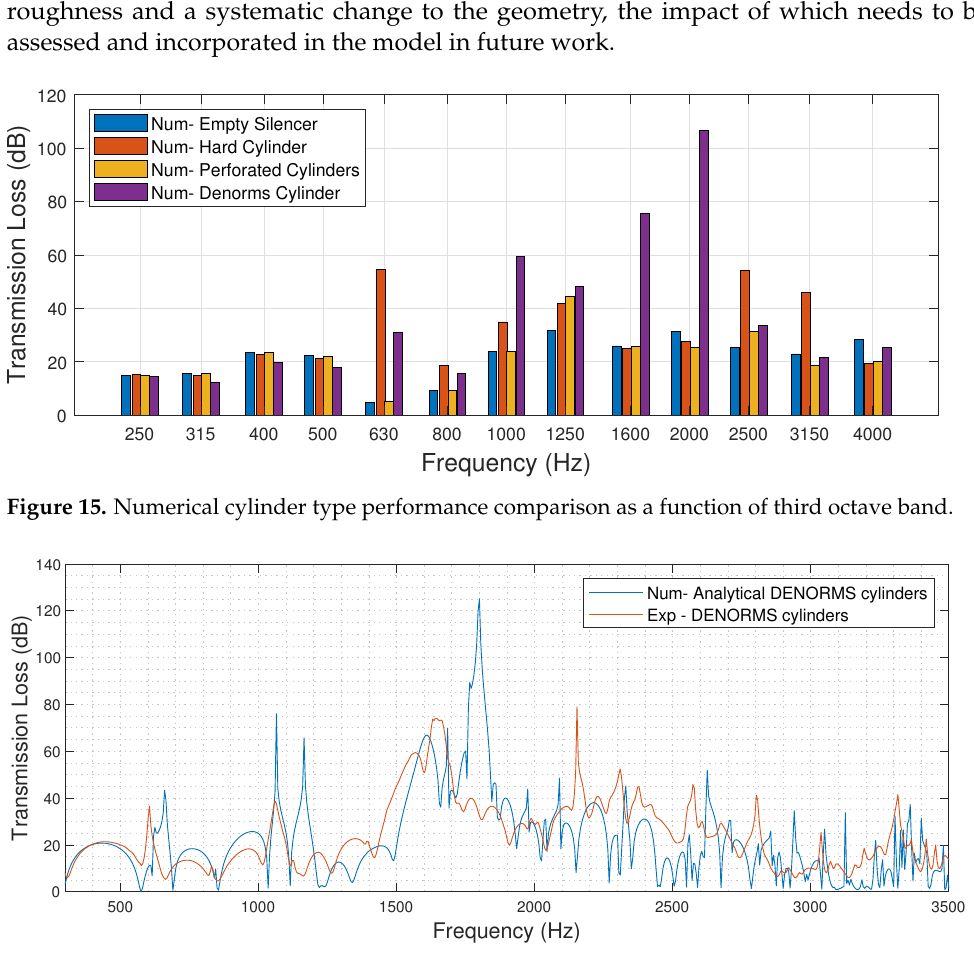
Figure 16. Experimental vs analytical